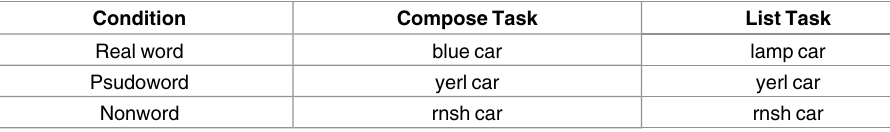
Table 1. Example stimulus set for the main